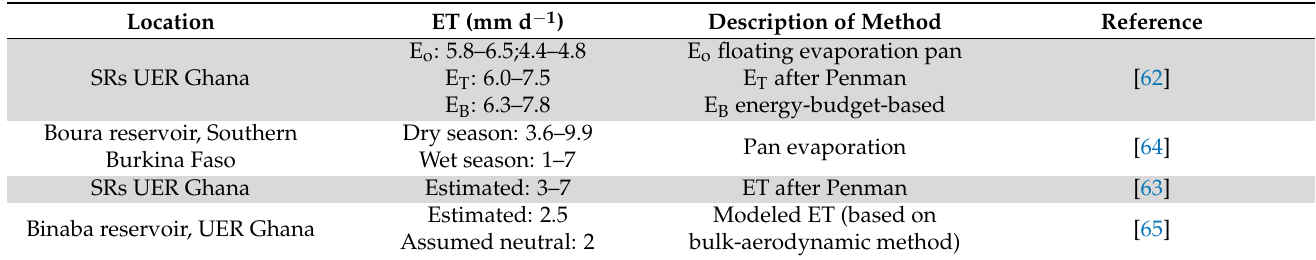
Table 6. Rates of reservoir evaporation in Ghana and Burkina